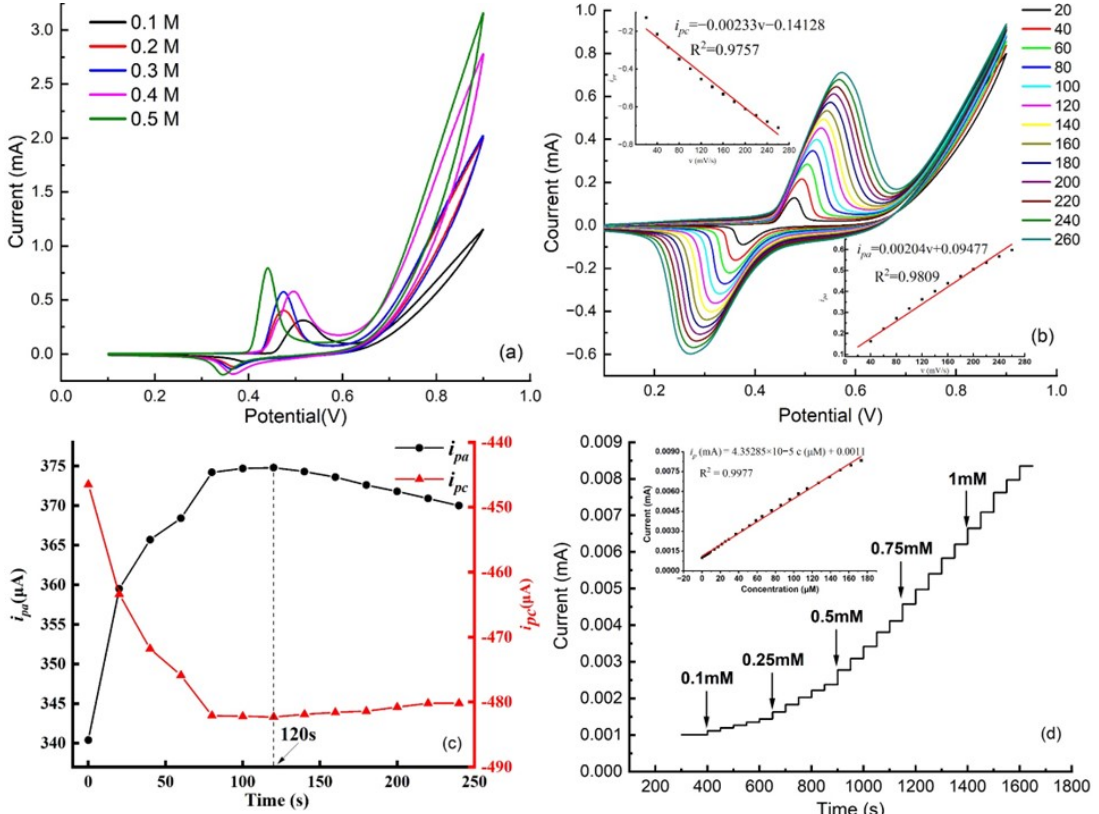
Figure 4. Electrochemical behavior of Glu at PASP/NiO/GCE: ( a ) CV curves of detecting 100 μ M Glu in Glu 0.1 M–0.5 M NaOH buffer; ( b ) CV curves of detecting 100 μ M Glu in 0.1 M–0.5 M NaOH buffer; ( c ) The relation between accumulation time and peak current of CV curve in 100 μ M Glu; ( d ) Chronoamperometric determination of Glu with PASP/NiO/GCE.